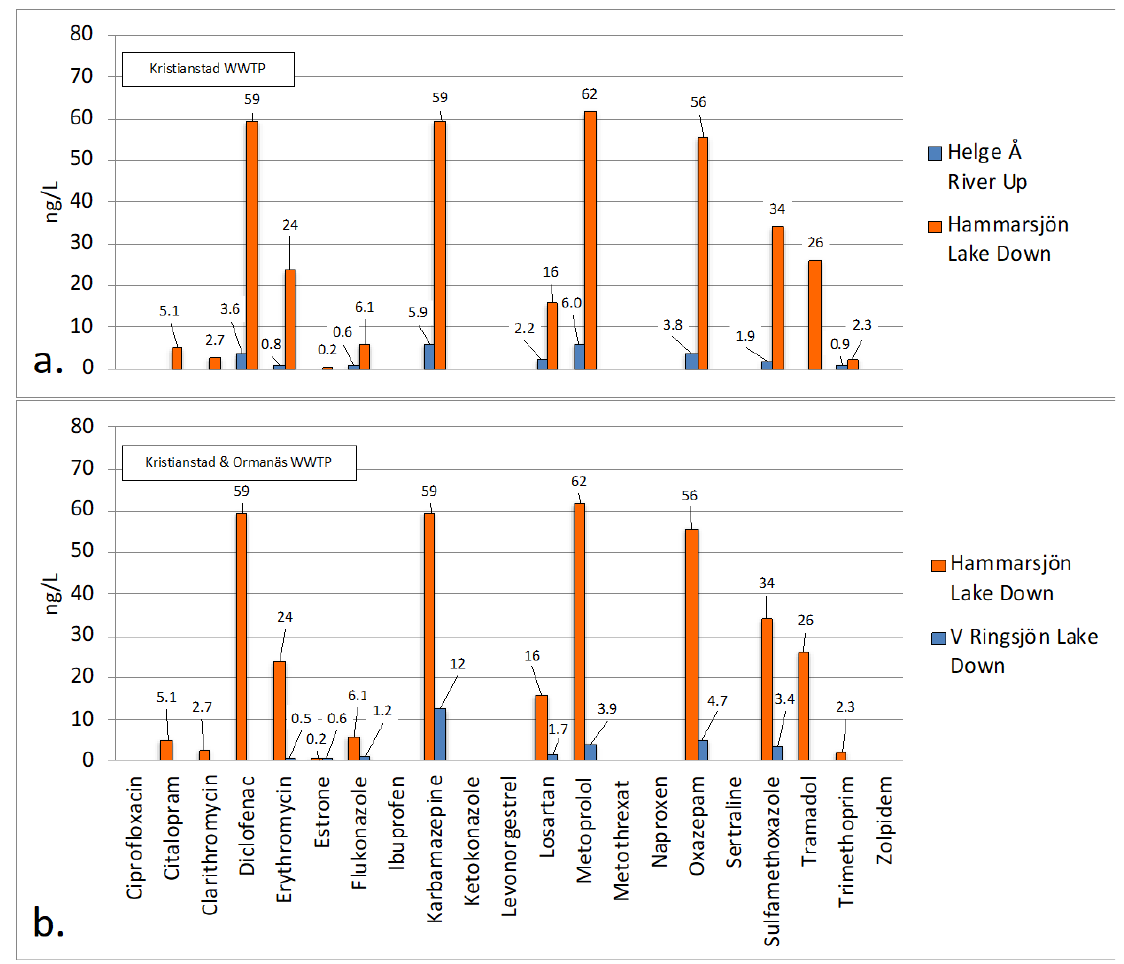
Figure 10. ( a ) Measured concentrations of pharmaceuticals in the Helge Å river upstream and the Hammarsjön lake downstream of Kristianstad WWTP. ( b ) Comparison of measured concentrations of pharmaceuticals in the Västra Ringsjön lake downstream Ormanäs WWTP and the Hammarsjön lake downstream Kristianstad WWTP.